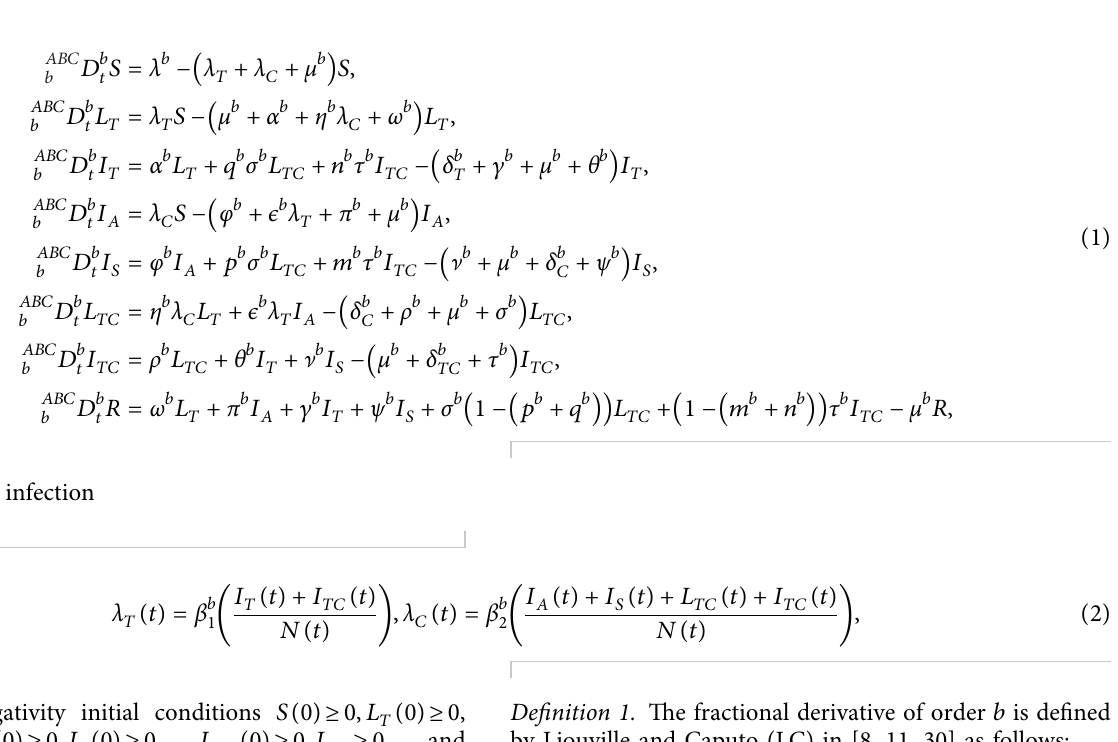
Figure 1: Schematic diagram of the tuberculosis-COVID-19